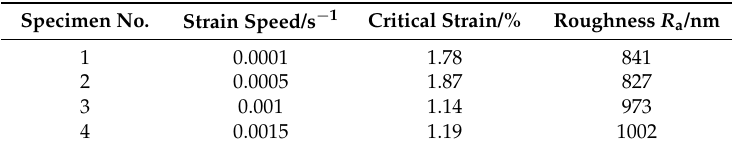
Table 2. Critical strain and roughness of